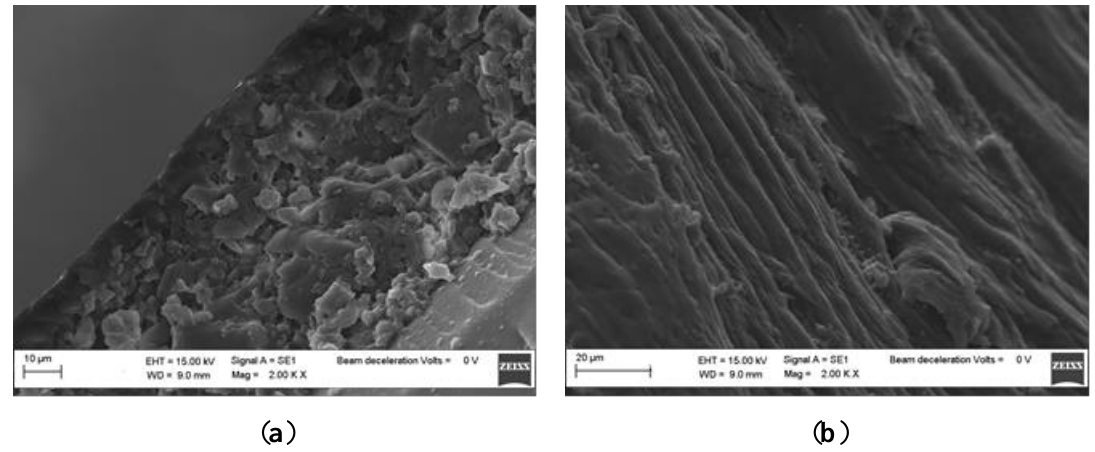
Figure 1. Section of a bacterial cellulose sample ( a ); Section of a sample of bacterial cellulose after treatment with ILs ( b ).